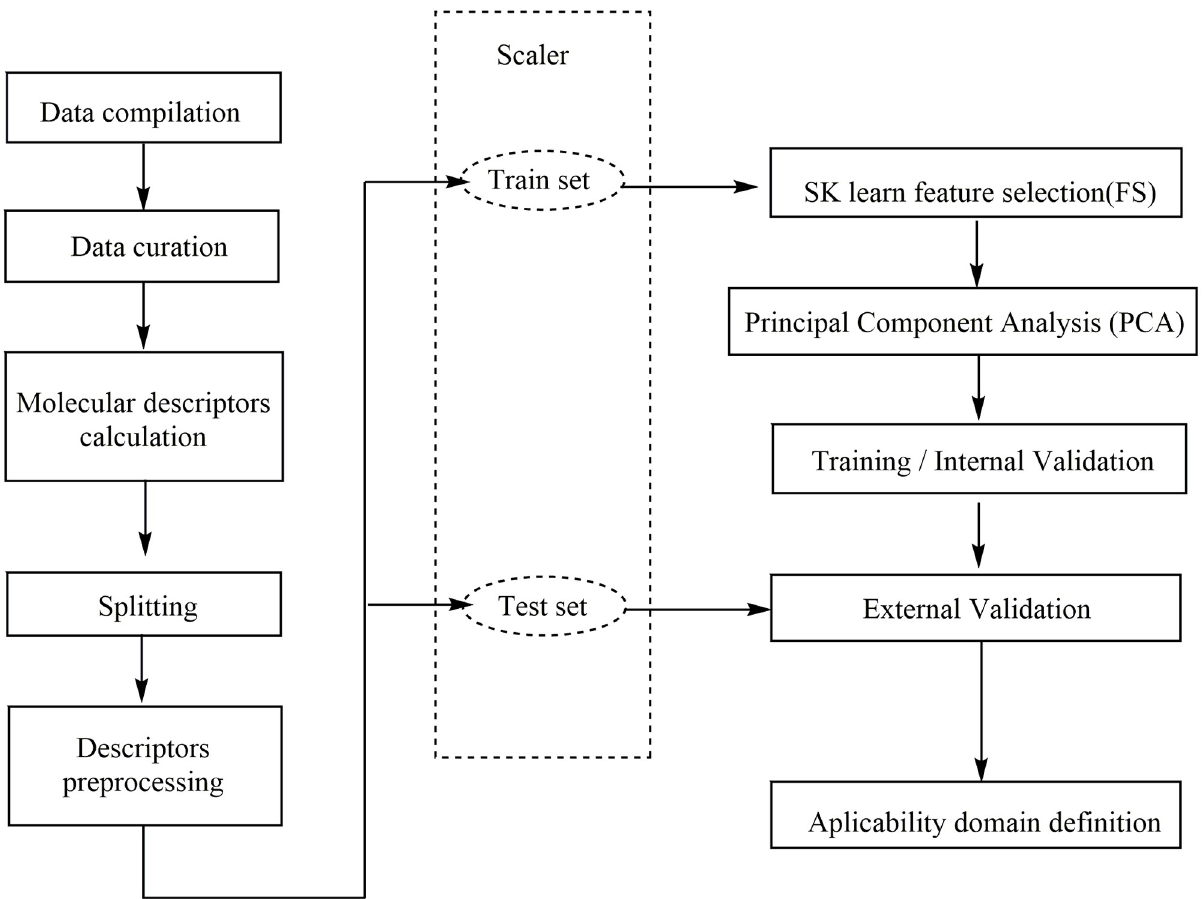
Fig 1. Workflow of the QSAR